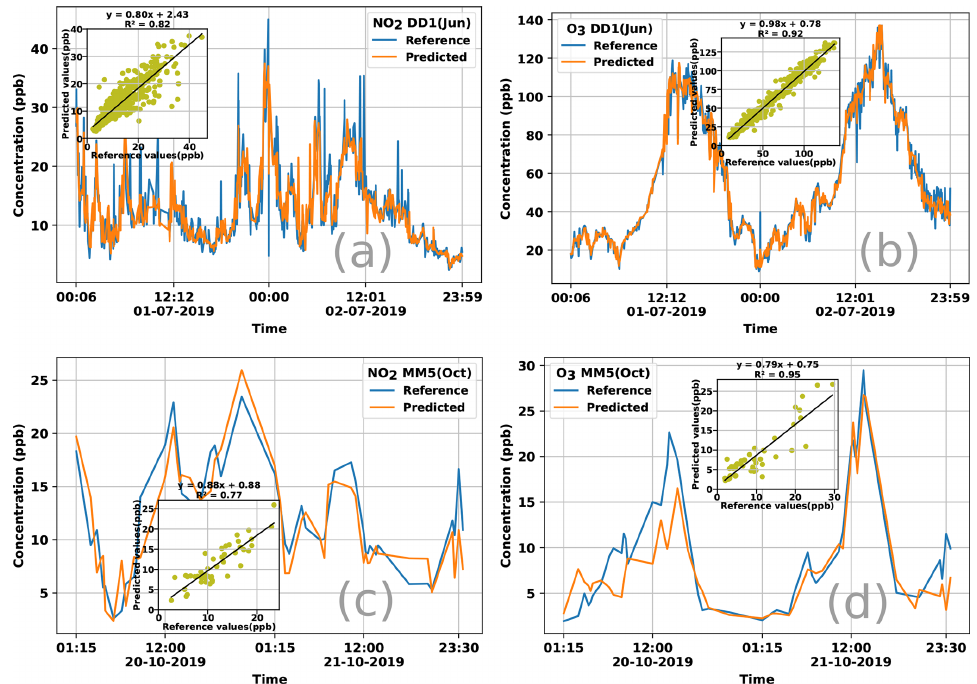
Figure 6. Time series plotting reference values and those predicted by the KNN-D(ML) algorithm for NO 2 and O 3 concentration for 48h durations using data from the DD1 and MM5 sensors. The legend of each plot notes the gas for which calibration is being reported and the deployment season, as well as the sensor from which data were used to perform the calibration. Each plot also contains a scatterplot as an inset showing the correlation between the reference and predicted values of the concentrations. For both deployments and both gases, KNN-D(ML) can be seen to offer excellent calibration and agreement with the FRM-grade